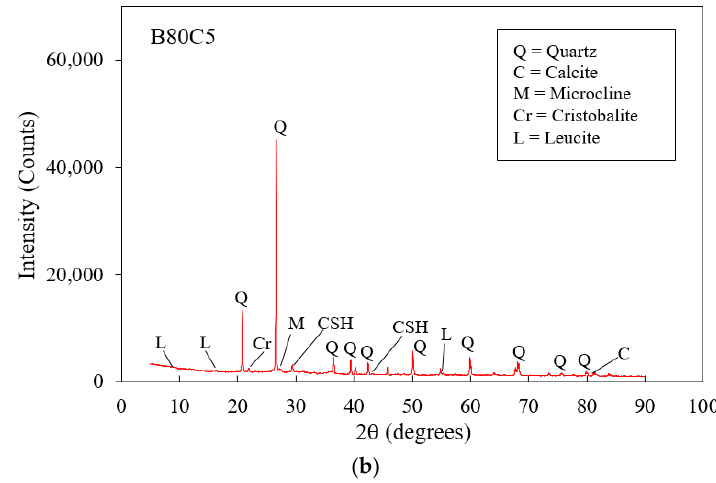
Figure 6. X-ray diffraction patterns: ( a ) B80; ( b ) B80C5.